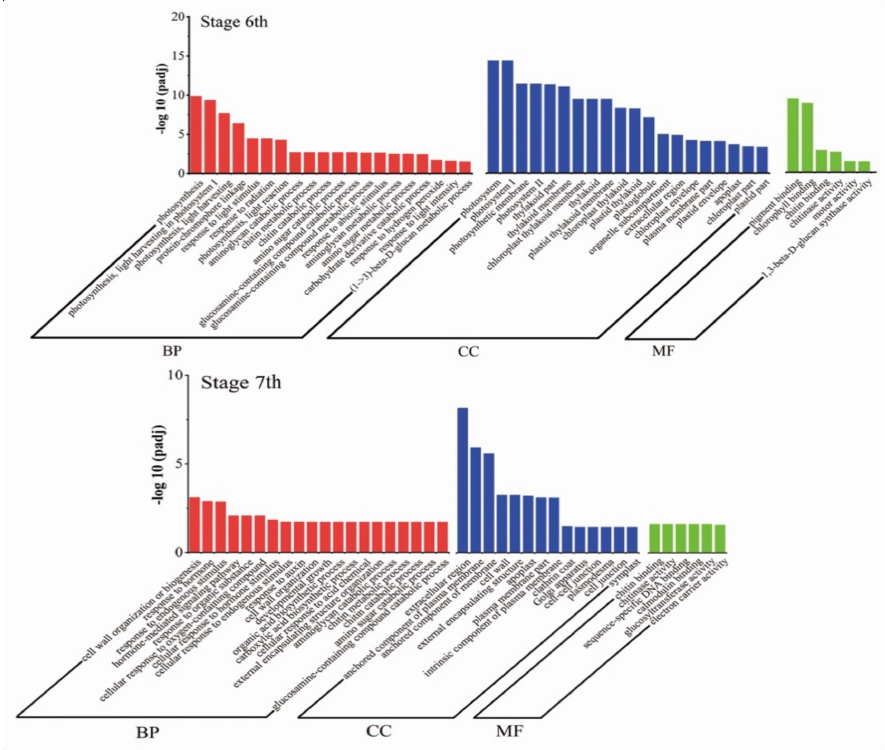
Figure 6. Gene Ontology (GO) analysis of DEGs in stages 6 and 7. Genes are classified into three major categories: biological process, cellular component, and molecular function. The X-axis indicates the − log10 (padj) of GO, and the Y-axis indicates the GO terms of genes.